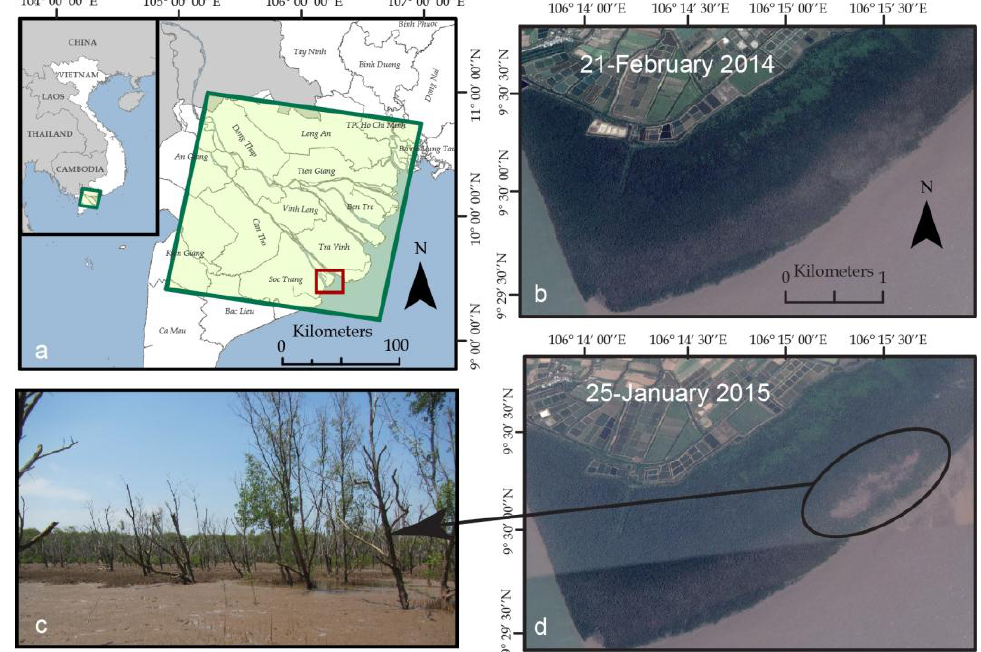
Figure 6. ( a ) Mekong river delta, Vietnam. Study area is in red box; ( b ) Aerial image